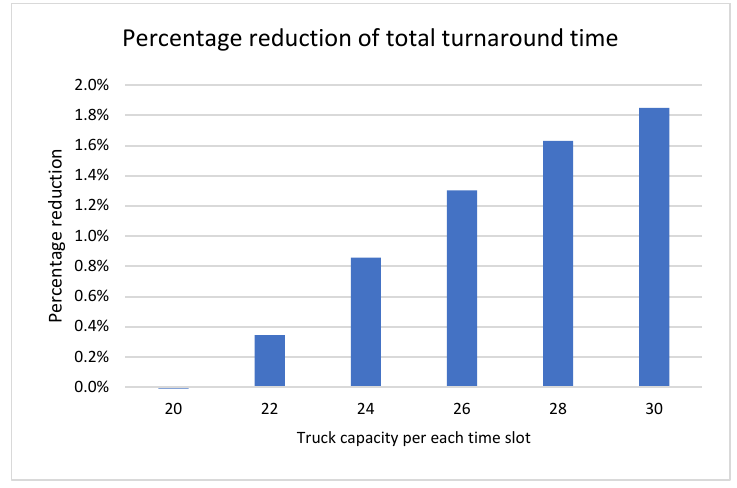
Figure 15. The percentage reduction of total TTT in each scenario after leveling the workload.